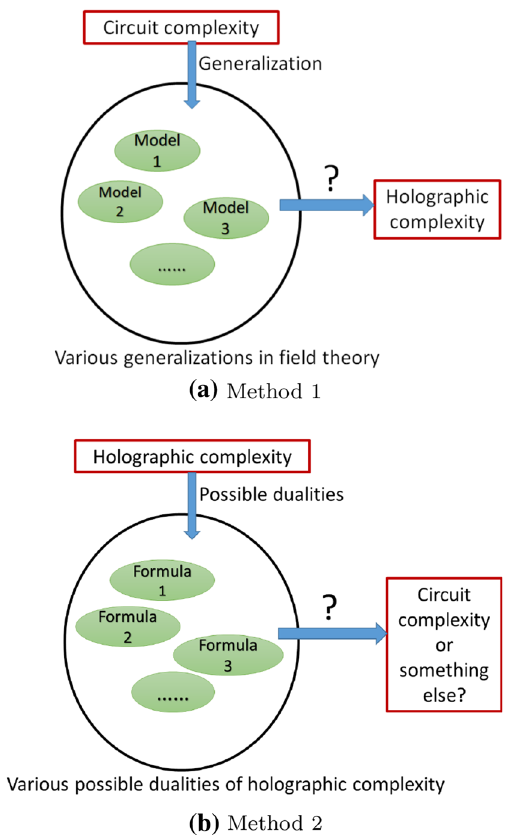
Fig. 1 Two different methods to understand the holographic complex- ity. a Assume that the holographic complexity is a precise dual of a specific generalization of the circuit complexity. We investigate differ- ent possible generalizations of the circuit complexity in field theory and then seek for the best one compatible with the holographic complexity. b Do not make any assumption on what the field theory dual of the holographic complexity is. First, just try to find out various possible candidates of the field dual of the holographic complexity. Next, we